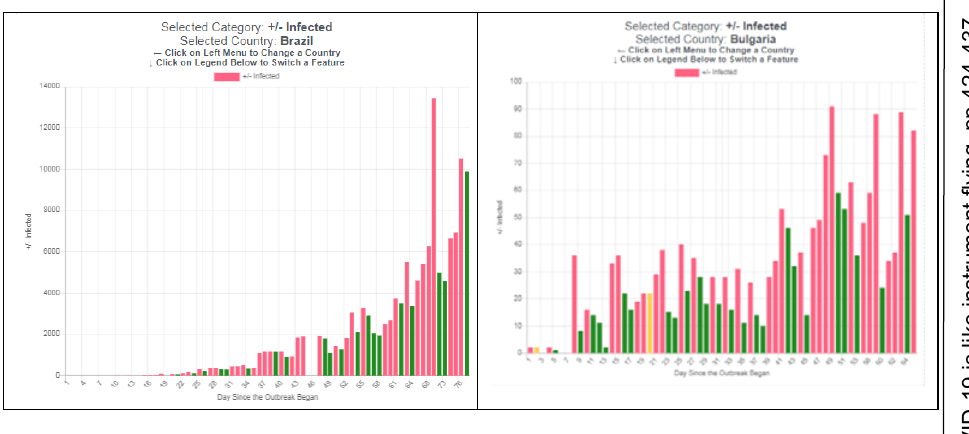
Figure 2 – Histograms a) Brazil, b) Bulgaria